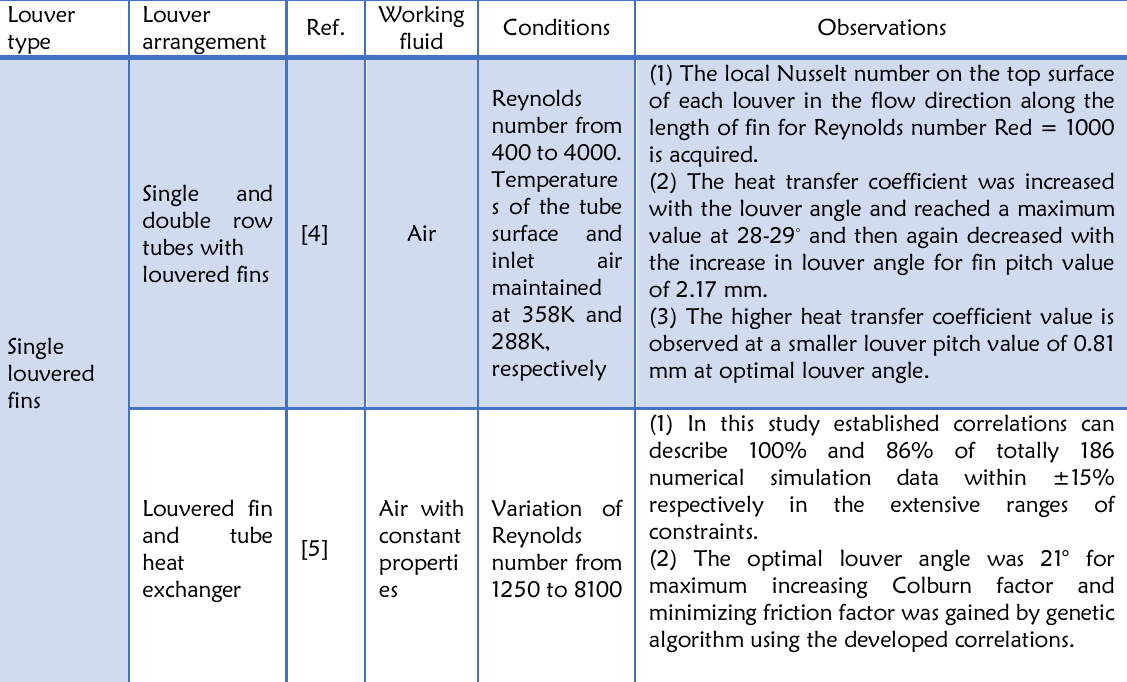
Table 4: Observation of recent investigations on various types of louver fin at different working conditions in term of heat transfer